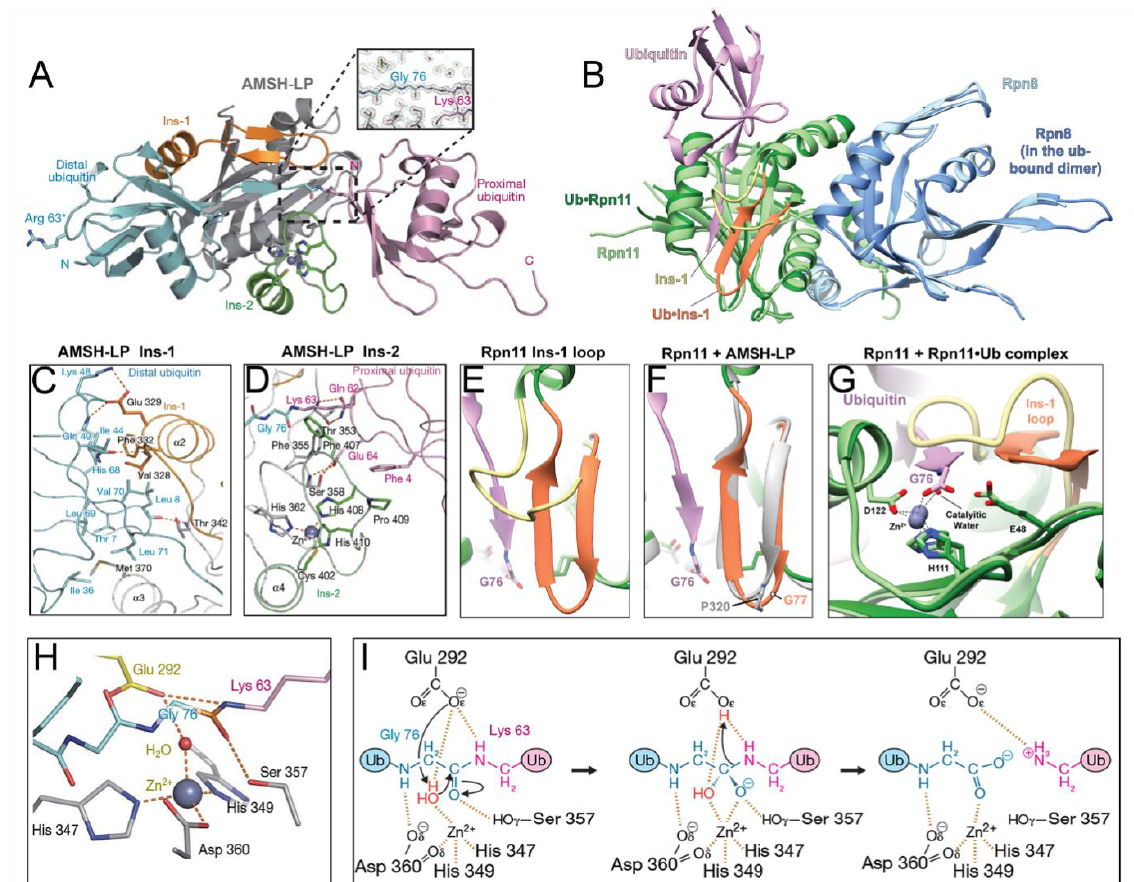
Figure 3. ( A ) Crystal structure of the AMSH-LP DUB domain in complex with K63-linked polyubiquitin chains (PDB ID: 2ZNV). The JAMM core, Ins-1, and Ins-2 are colored gray, orange, and green, respectively. The proximal and distal ubiquitins are colored pink and cyan, respectively. ( B ) Superimposition of the crystal structures for the Rpn11-Rpn8 heterodimer with ubiquitin (PDB ID: 5U4P, green, blue, and pink, respectively) and the ubiquitin-free Rpn11-Rpn8 heterodimer (PDB ID: 4O8X, light green and light blue). ( C , D ) The interfaces between AMSH-LP and the distal/proximal ubiquitin. ( E ) Close-up view of the Ins-1 loop in the ubiquitin-free state (tan) and the ubiquitin-bound state (orange). ( F ) Superimposition of the Ins-1 loop of Rpn11 in the ubiquitin-bound state with the Ins-1 loop of AMSH-LP in the ubiquitin-free state (PDB ID: 2ZNR). The Ins-1 loop of AMSH-LP always occupies the β -hairpin conformation, even in the absence of ubiquitin. ( G ) Close-up view of the superimposed active sites of Rpn11 in the ubiquitin-free (light green) and ubiquitin-bound (green) states. ( H ) The catalytic domains of AMSH-LP. The catalytic Zn 2+ ion is complexed to His 347, His 349, and Asp 360 and an activated water molecule to attack the isopeptide bond of ubiquitin chains. ( I ) Take AMSH-LP as an example, the schema represents a proposed catalytic mechanism of JAMMs. Panels A, C, D, H, I, and B, E – G are adapted with permission from [26,39], respectively.